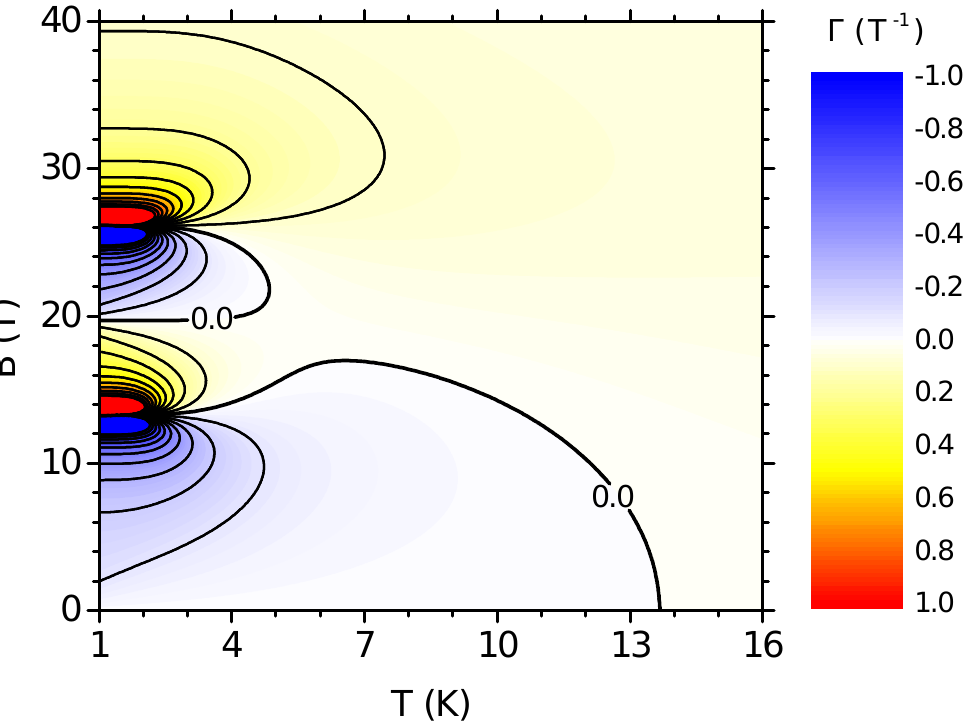
Figure 11. The density plot with contours showing the magnetic Grüneisen ratio as a function of the temperature and the external magnetic